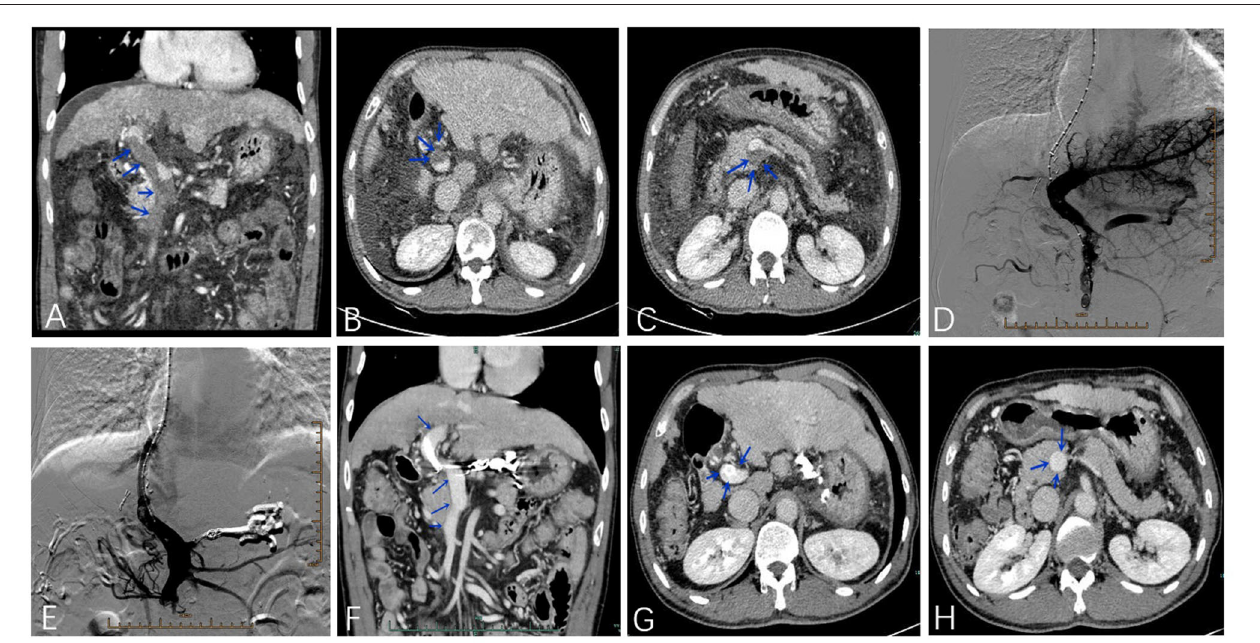
FIGURE 2 | A 55-year-old male patient was treated with TIPS due to esophagogastric varices bleeding with PVT in the main portal vein and superior mesenteric vein (A–C) . The portal venogram before (D) and after (E) stent placement. Four months after the operation, the thrombosis disappeared in the main portal vein and superior mesenteric vein (F–H) .